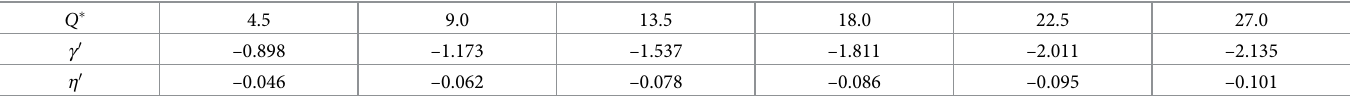
Table 4. The values of fitting coefficients γ 0 and η 0 .